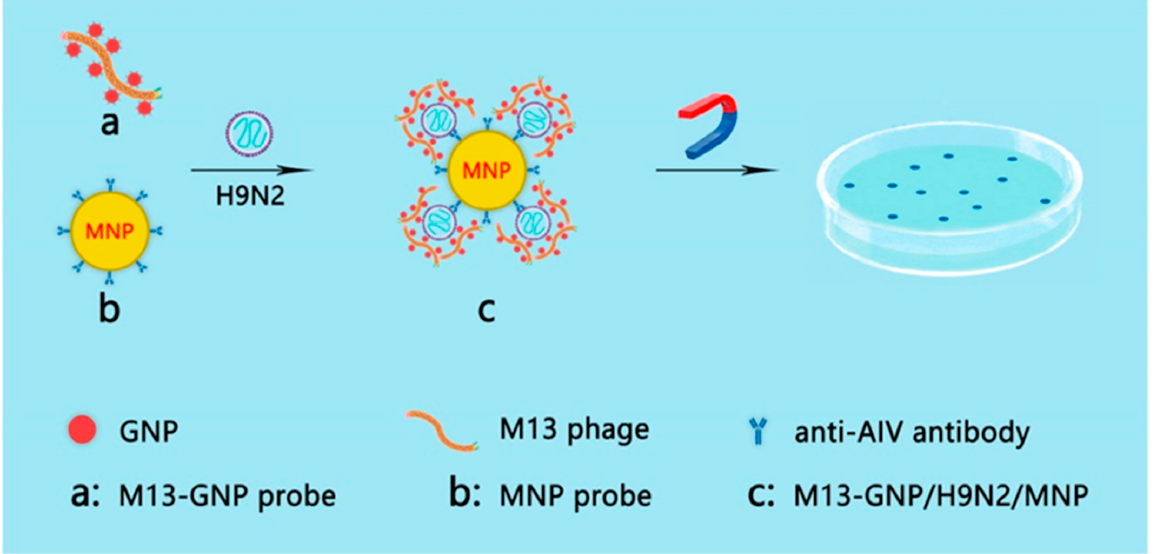
Figure 5. Strategy of counting viruses with the naked eye. ( a ) M13@GNP probes were prepared by assembling M13 phage with GNPs modified with antibodies against M13 p8 and with antibodies against H9N2 virus; ( b ) magnetic nanoparticles (MNP) probes were prepared by mixing MNPs with the monoclonal antibodies against H9N2 virus; ( c ) sandwich complex formed by H9N2 viruses captured by both M13@GNP and MNP probes. The M13 phages were separated from the complex and plated to infect host E. coli ER2738 on LB agarose plate with IPTG/Xgal. The blue plaques indicate the presence of H9N2 virus